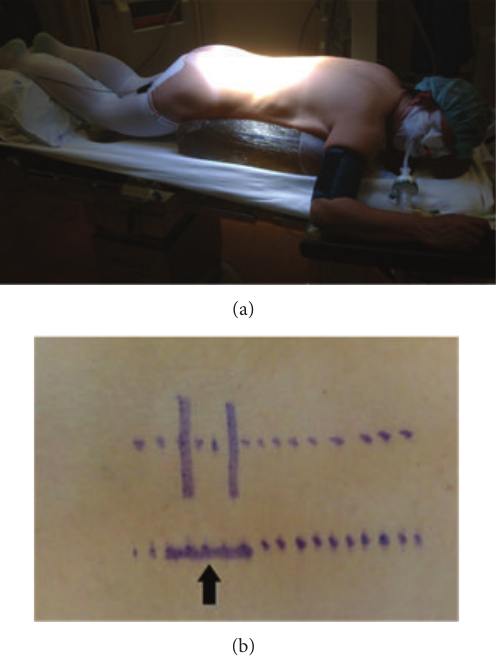
Figure 3: (a) Patient positioning and (b) preoperative planned skin incision